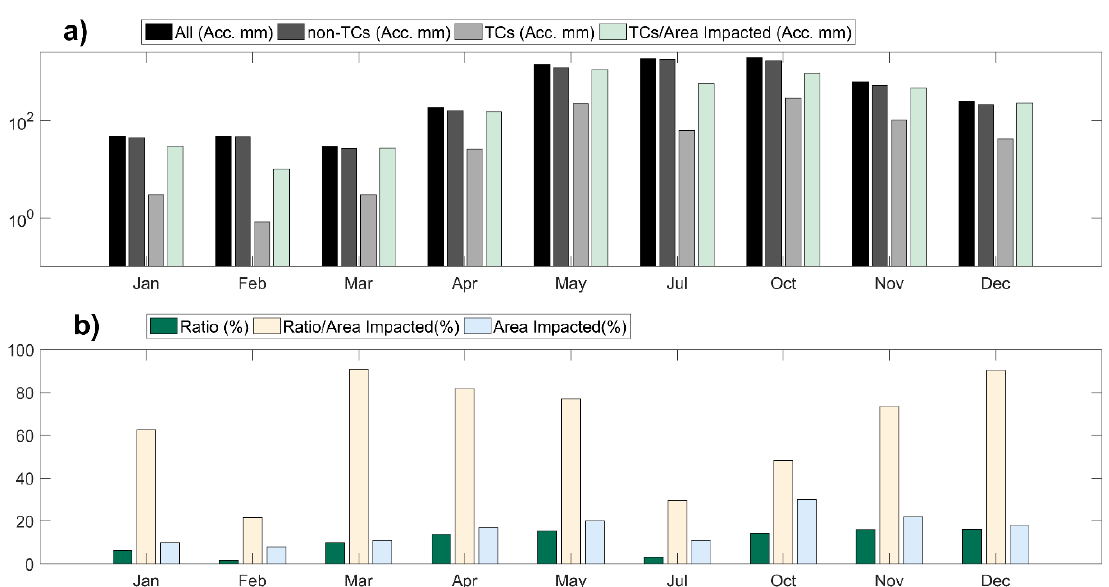
Figure 11. ( a ) Monthly rainfall accumulation over land for all rainfall events, TCs, non-TCs, and TCs / Area Impacted, ( b ) rainfall contribution and the proportion of area impacted by TCs. The y-axis ( a ) represents a log scale for rainfall accumulation (mm).